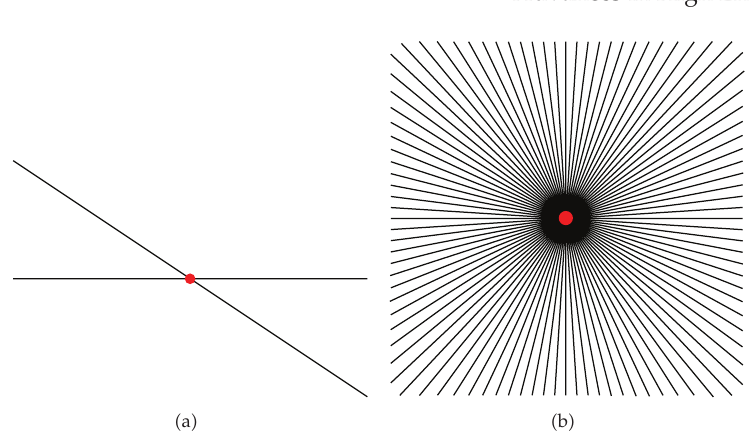
Figure 2: (cid:5) a (cid:6) A point-like charge (cid:5) in red (cid:6) and two lines of charge at di ff erent angles. (cid:5) b (cid:6) A configuration with many lines of charge. In the asymptotic limit of an infinite number of lines, they just correspond to a radial charge density. This picture depicts an analogous situation to the case of smeared flavored branes, when the fundamental fields are